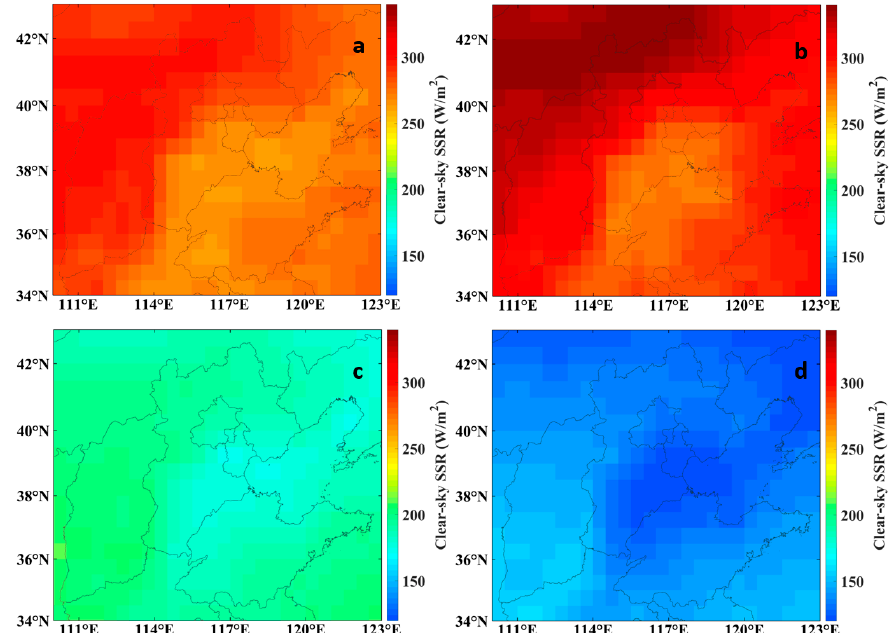
Figure 5. Spatial distribution of seasonal mean clear-sky SSR in northern China from 2001 to 2015: ( a ) Spring; ( b ) Summer; ( c ) Autumn; and ( d ) Winter.